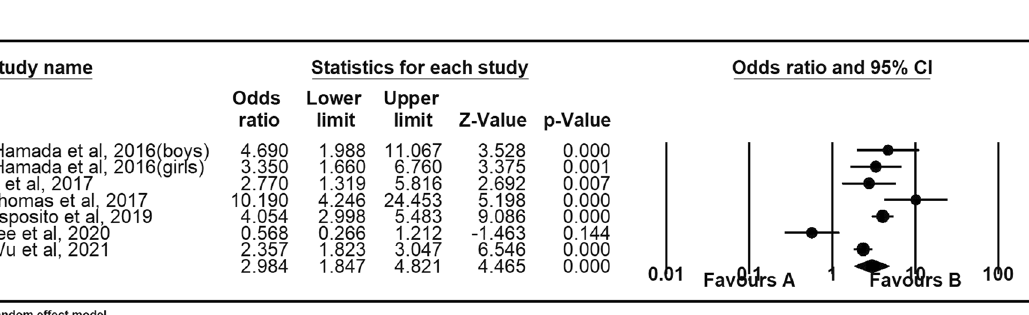
Figure 6. Forest plot for the effect sizes comparing the NSSI of Bully-Victims with children not involved in